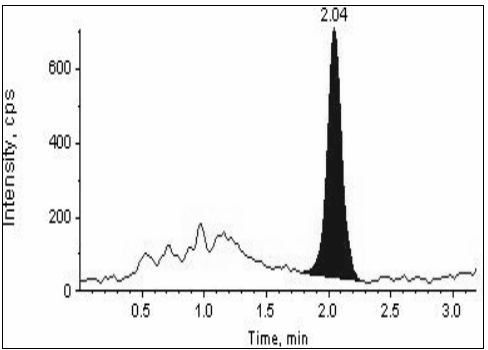
Figure 4. Representative chromatogram plasma spiked with metolazone at the lower limit of